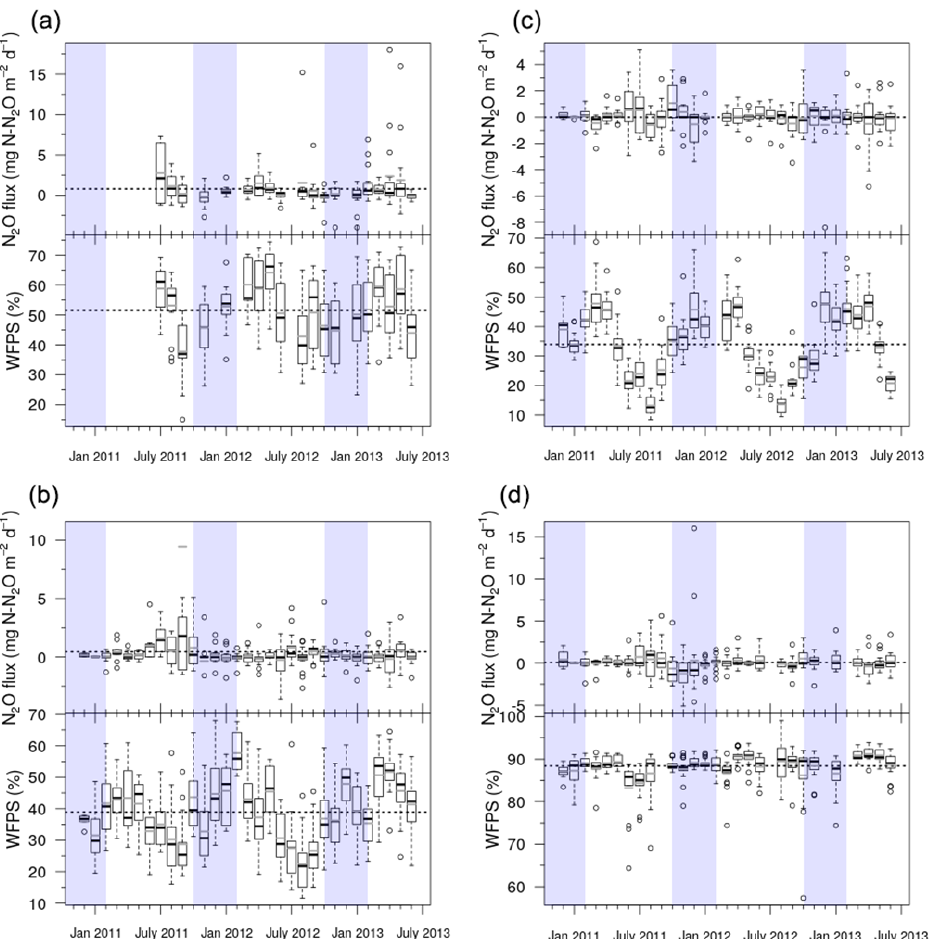
Figure 3. Time series of net N 2 O flux and water-filled pore space (WFPS). Panels indicate data for (a) premontane forest, (b) lower montane forest, (c) upper montane forest, and (d) montane grasslands for the 30-month study period beginning in January 2011 and ending in June 2013. The broken horizontal line running across each panel denotes the overall mean N 2 O flux or WFPS for that habitat. The dashed line in each box indicate median values and the black lines indicate means. Dry and wet seasons are denoted by vertical shading on the graph, with the dry season (May to September) highlighted in white and the wet season (October to April) in light